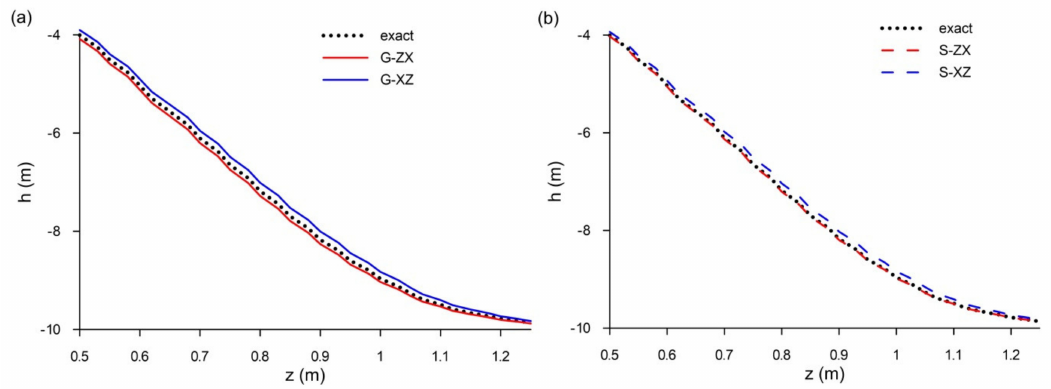
Figure 6. Water saturation profiles along z (vertical) direction at the cross-section x = 0.5 m after 1000 s ( ∆ t = 50 s, η = 0.5) obtained using various splitting algorithms: the Godunov method ( a ); the standard Strang method ( b ).